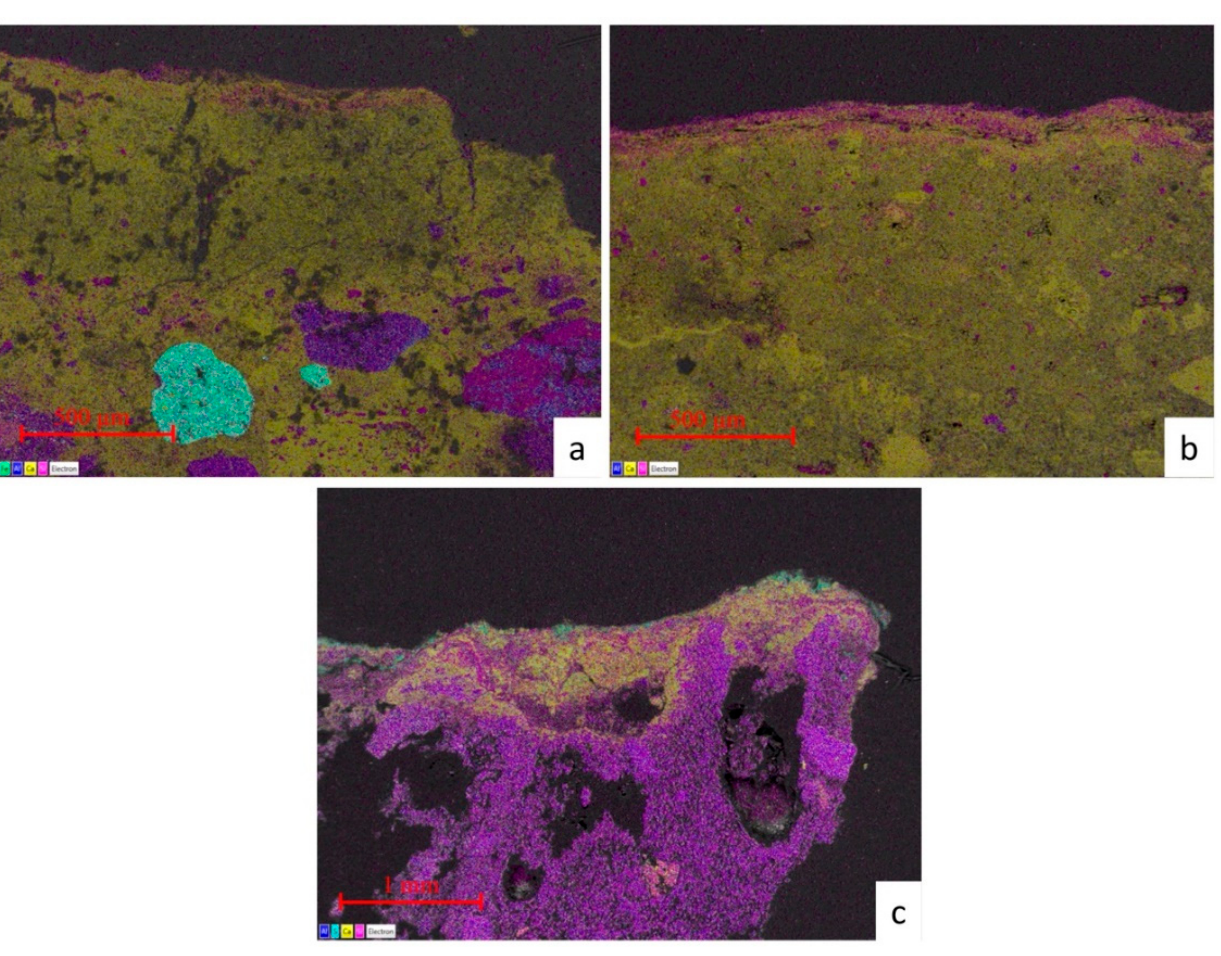
Figure 7. SEM maps of chemical elements in the samples collected by ( a ) the niche, the first preparatory layer and the plaster below; ( b ) the recumbent figure, the two lime layers; ( c ) the pediment, the unique white layer. Fe, green; Si, pink; Al, blue; Ca, yellow; S, cyan. The micro-chemical analysis of a white surface fragment collected by the winged figure in the pediment shows a predominantly SiO 2 composition, whose content is around 96% (Figure